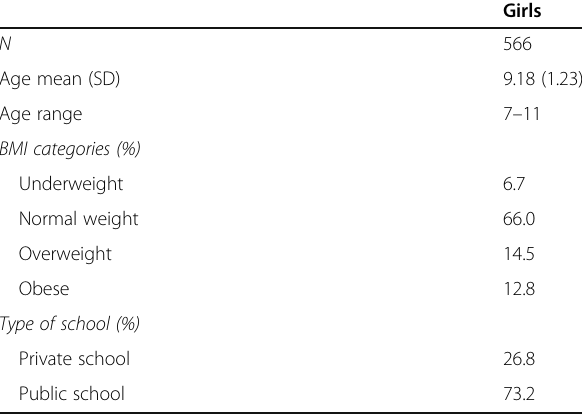
Table 1. The girls ’ sample has been divided randomly into two equal proportions ( n = 283) in order to be used for EFA and CFA. Instruments Sociocultural Attitudes